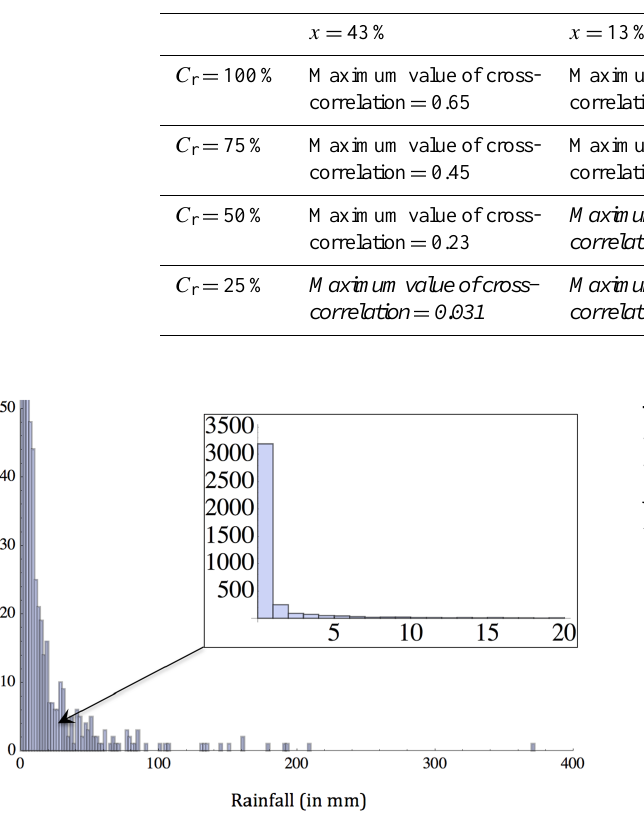
Table 3. Values of the cross-correlation between rainfall and rockfalls for three virtual databases, with a time delay of zero days. This value is compared to the significance threshold, which is equal to 0.031 in all cases. The results presented in italic identify the non-significant correlations (values equal to the threshold value were also considered insignificant).